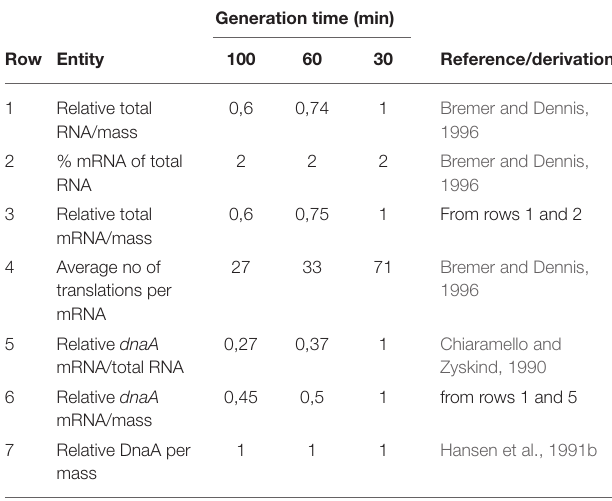
TABLE 1 | DnaA protein production at different growth